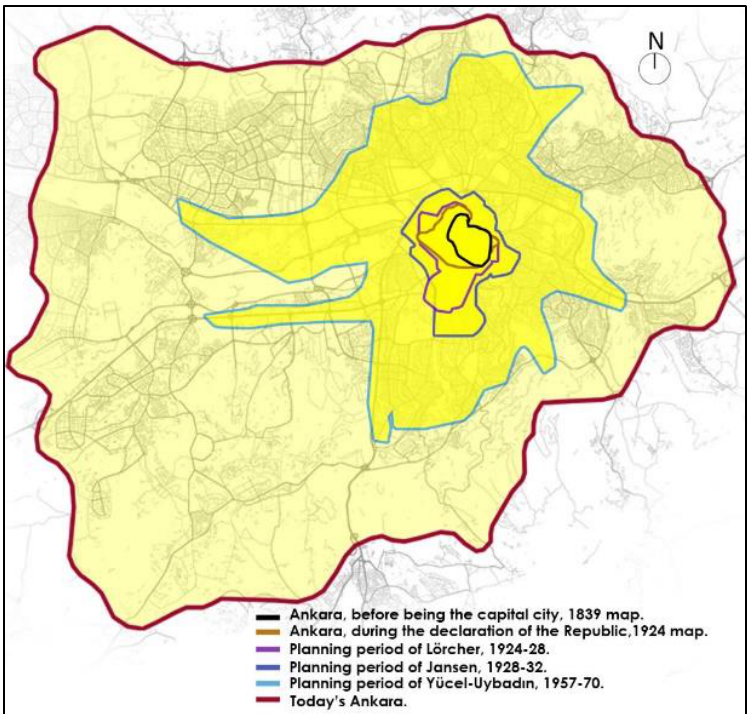
Figure 5 The city boundaries of the six periods